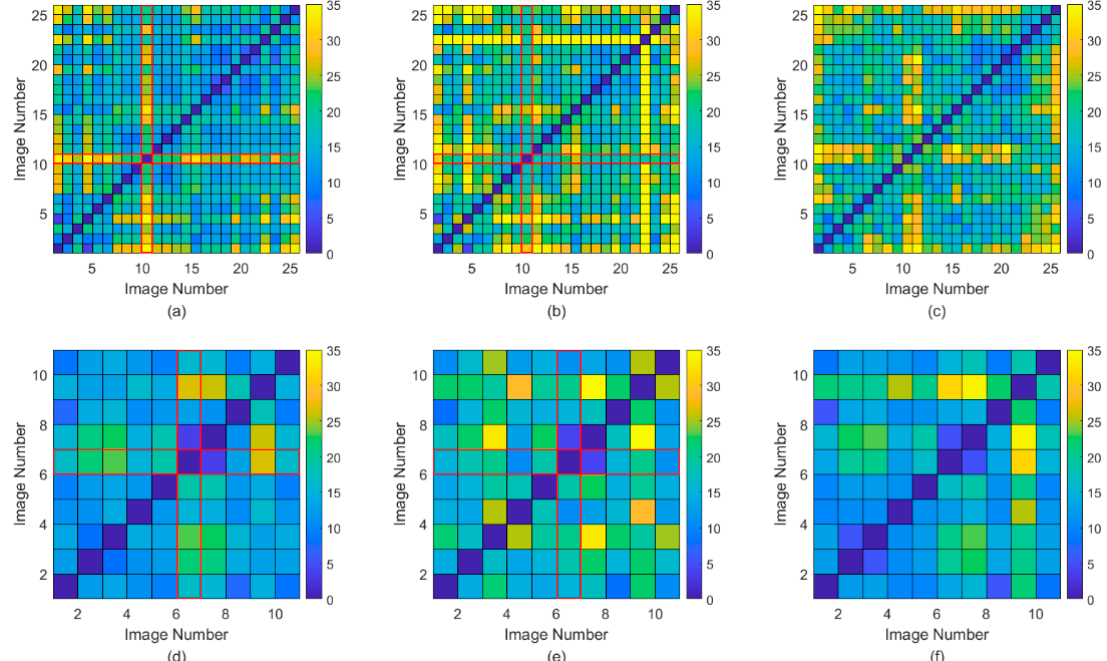
Figure 9. Error matrices of the Root Mean Squared Error (RMSE) using the proposed method and the two contrasting methods. As the color transitions from yellow to blue, the residual gradually decreases. ( a ) Error matrix of our method for experiment 1; ( b , c ) represent error matrices of the two contrasting methods for experiment 1; ( d ) error matrix of our method for experiment 2; ( e , f ) represent error matrices of the two contrasting methods for experiment 2.